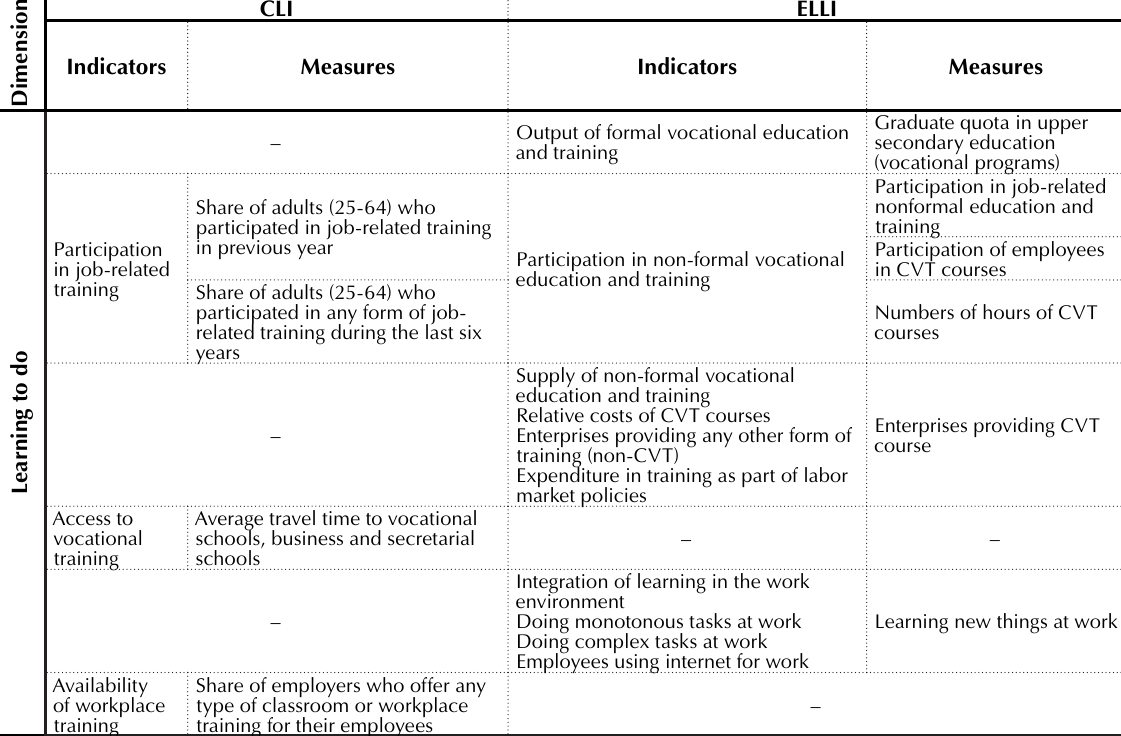
Table A2. The dimension of learning to do Source: Developed by the authors on the basis of the 2010 Composite Learning Index (2010) and Hoskins, Cartwright, and Schoof